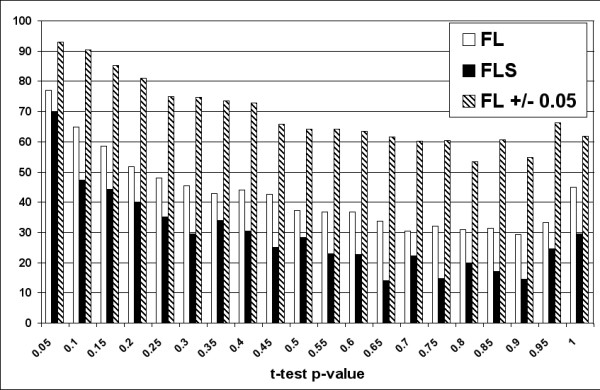
Percentage of predicted genes by Limma in the same p-value range of PreP+07 predictions. White bars belong to protocol 1 (FL), black bars correspond to protocol 2 (FLS) and slashed bars belong to protocol FL with neighbouring (a range of ± 0.05). Note the high coverage value (> 90%) for the most significant genes (p-value < 0.1) and that fact that major differences are produced in the low quality expression levels. The general coverage is approximately 70%.